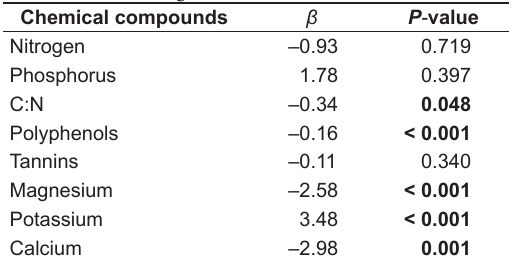
Table 1. Summary of final multiple regression model to test for correlation ( β ) between concentrations of chemical compounds of leaves and density of associated invertebrates during leaf